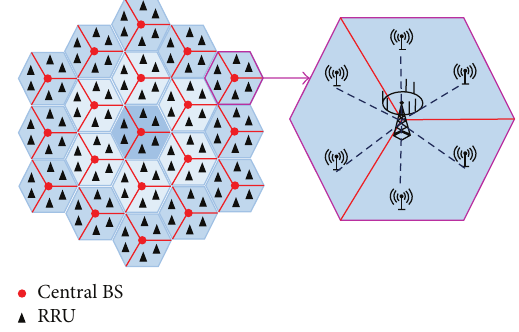
Figure 1: Example of considered DAS, consisting of 19 cells with 2- 2/1 configuration. Each cell contains one sectorized central BS which each sector equipped with 2 central-antennas and 2 RRUs that each of which equipped with one antenna and connected to the central BS via fiber